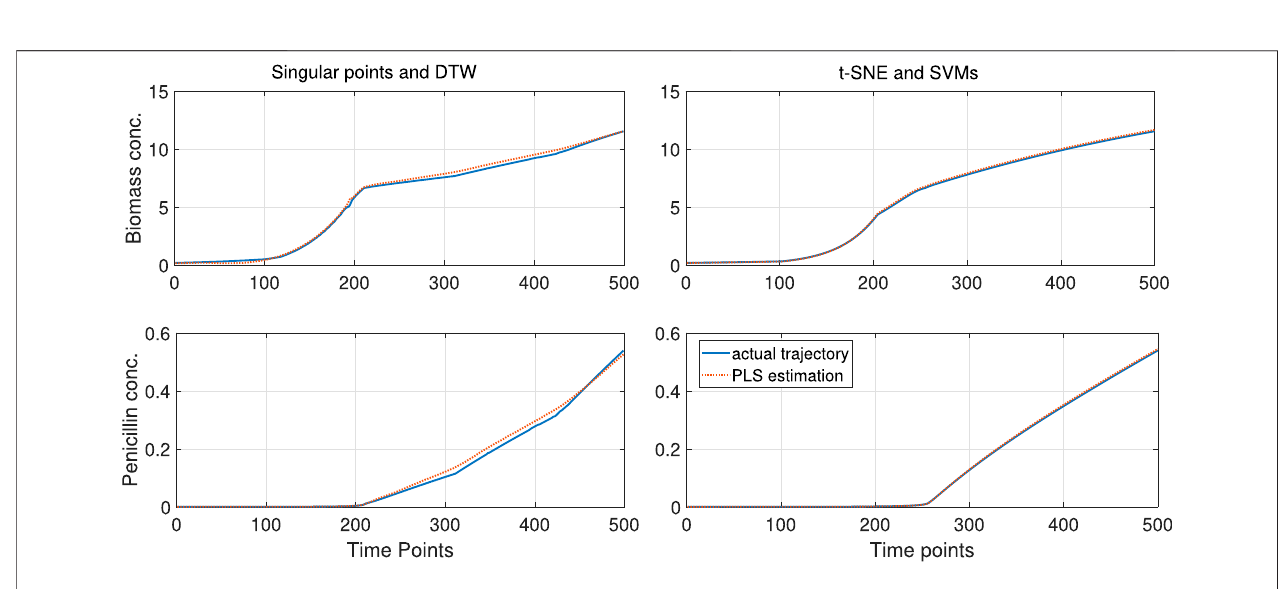
FIGURE 11 | Results on the fault detection for the Pensim process. Temporary drop in the aeration rate.